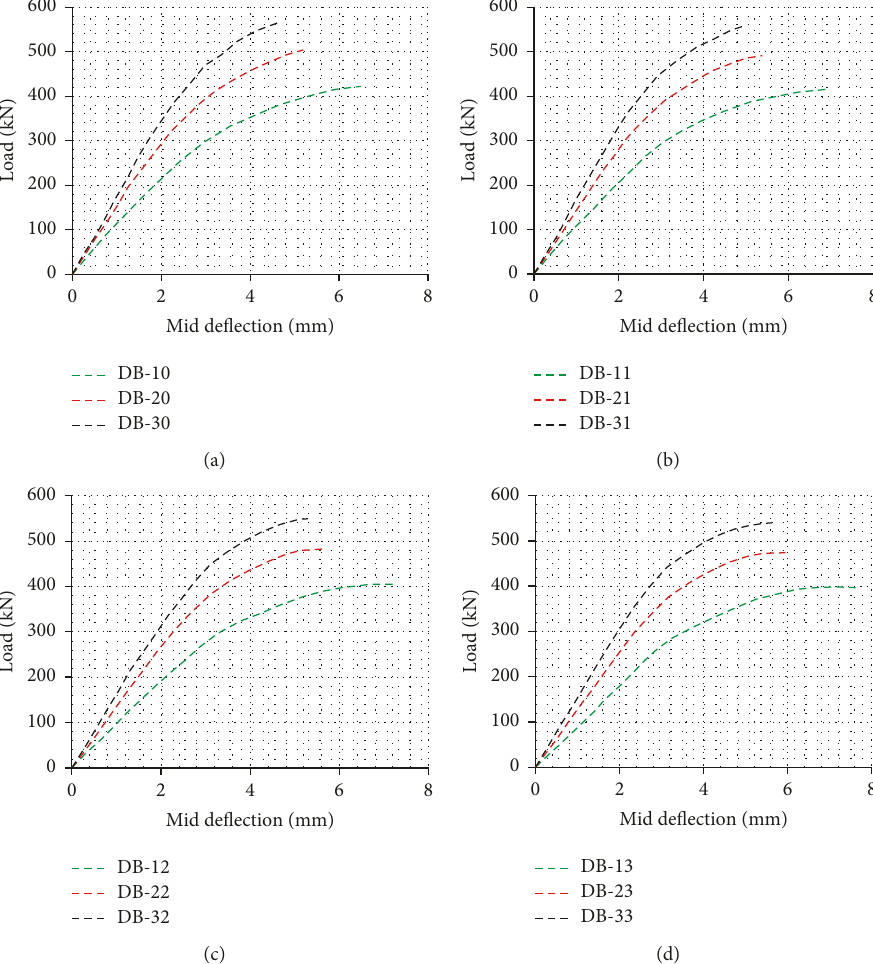
Figure 8: Load-deflection response curves with different L/D ratios of 3, 2.67, and 2.4. (a) Straight beam, (b) beam with L/R ratio equal to 1.05, (c) beam with L/R ratio equal to 1.31, and (d) beam with L/R ratio equal to 1.57.